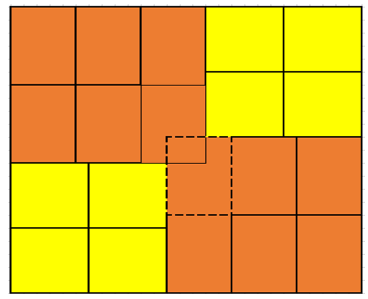
Figure 7. Single object overlap.